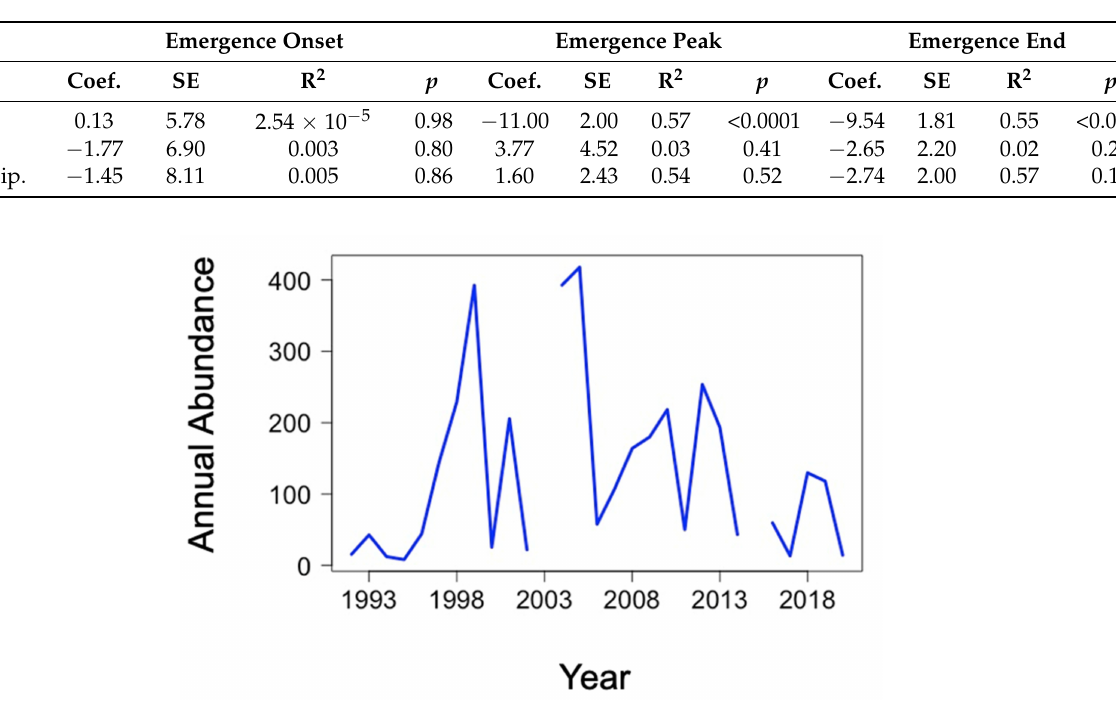
Table A1. Linear regression models of the onset, peak, and end of emergence of Calliphora vicina in